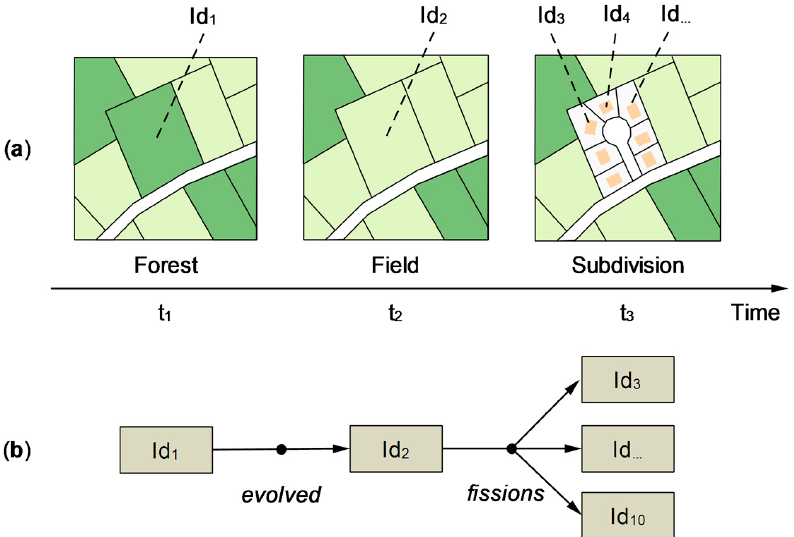
Figure 5. Example of the evolution of a land area represented by states and transitions, ( a ) repre- sentation of the real-world entities, ( b ) geographic objects’ changes through a succession of states (rectangles) and transitions (arrows).